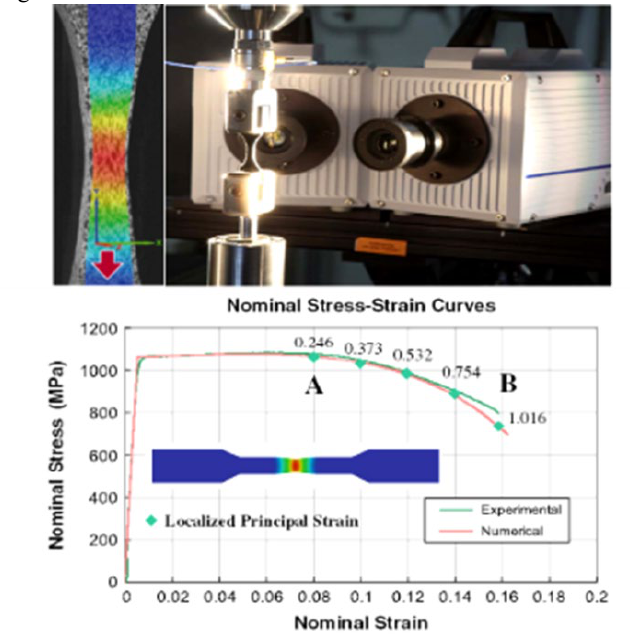
Figure 2. Digital image correlation test system.